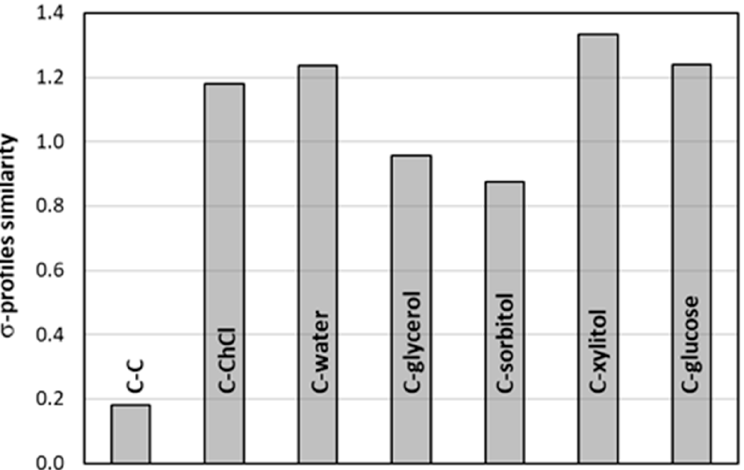
Figure 10. Comparison of σ -profiles similarities of studied complexes of caffeine with ccNADES constituents and water. As a measure of similarity, the RMSD (root-mean-square deviations) values were computed for σ -profiles presented in Figure 9 of pairs (“ mcos ” file) with respect to monomeric caffeine (“ cosmo ” file).